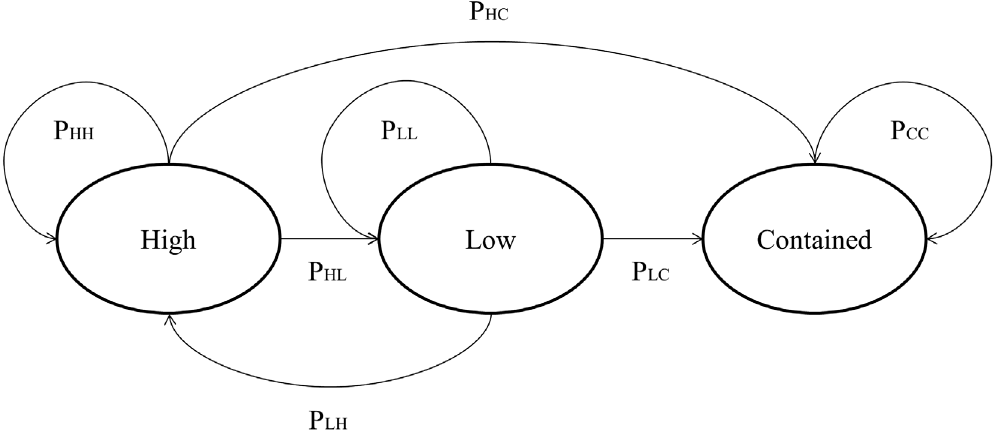
Figure 3. Conceptual representation of Markov Chain model of incident complexity dynamics. Here only three states – high complexity, low complexity, and incident contained – are used to simplify presentation of the system. The contained state is presented as an absorbing state (i.e., P CC =1).